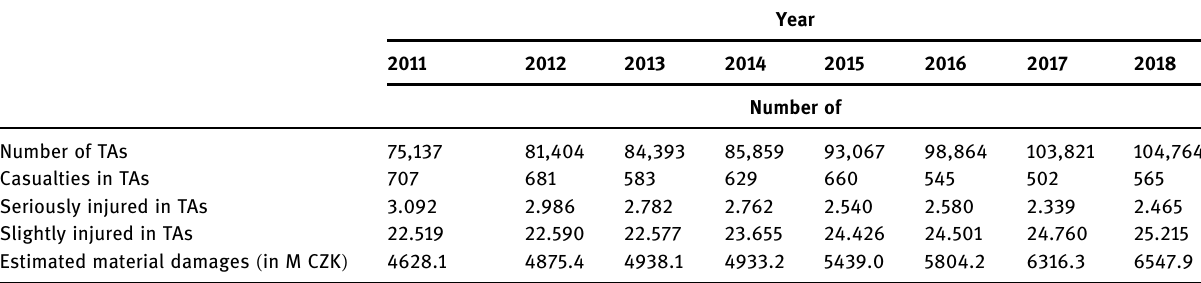
Table 1: The number of fatalities and injuries in TAs, and estimated material damage between 2011 and